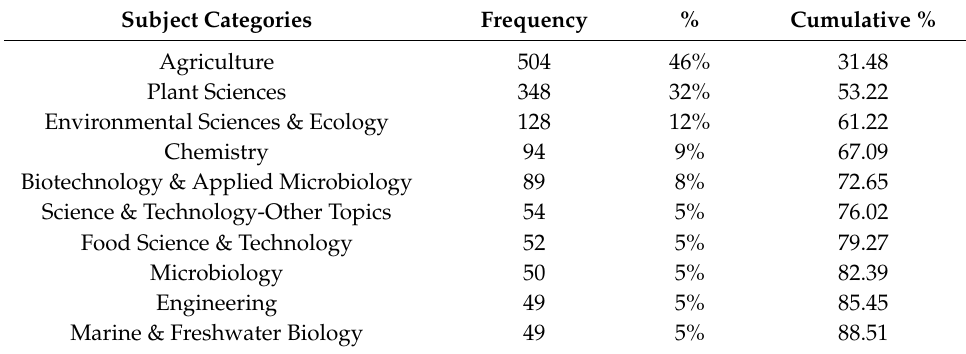
Table 3. Scientific macroareas in which research on biostimulants is concentrated.